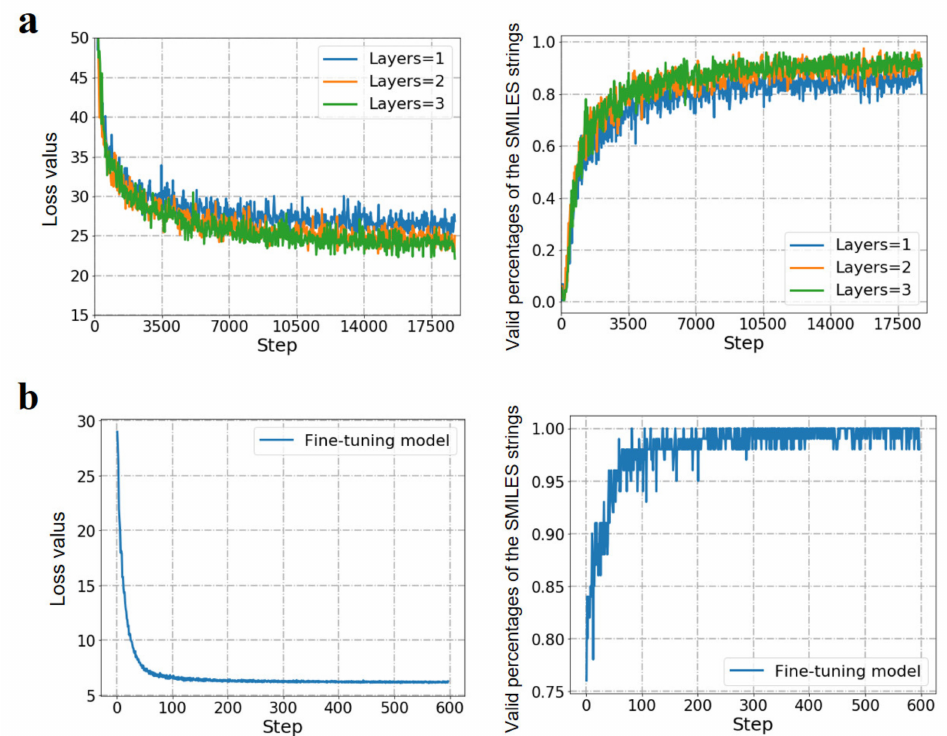
Figure 5. Performances of the pre-trained RNN models with different GRU layers ( a ) and the fine-tuned RNN model by transferred learning of 433 caspase-6 inhibitors ( b